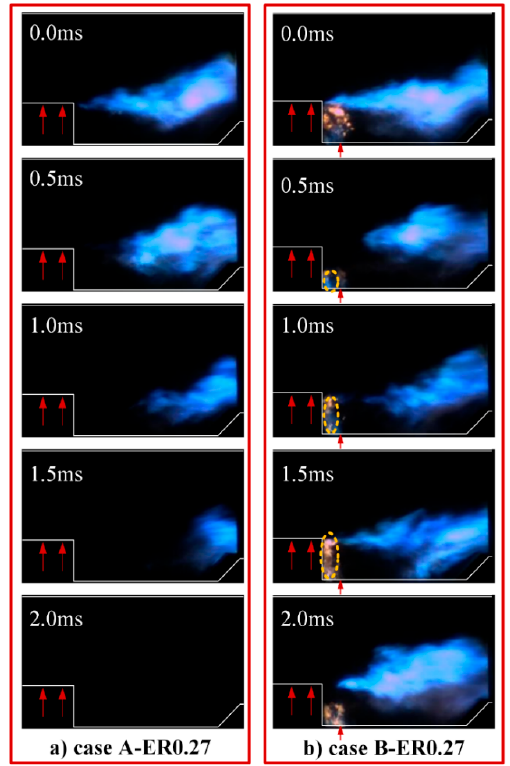
Figure 7. Comparison of flame development processes with different injection schemes at ER = 0.27 (the flame blowoff process is shown in ( a ) case A-ER0.27, and the mechanism of flame stabilization by the additional cavity floor injection is shown in ( b ) case B-ER0.27).